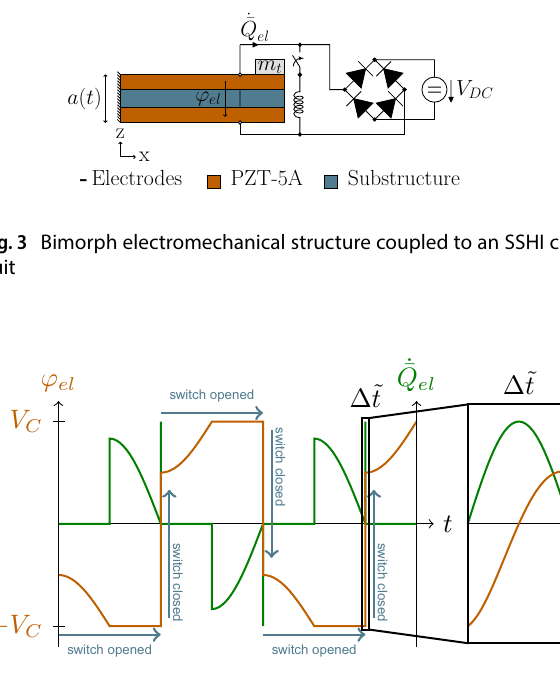
Fig. 4 Typical waveforms of 𝜑 el , and ̇̄ Q el arising from the SECE cir- cuit under a harmonic base excitation of the electromechanical